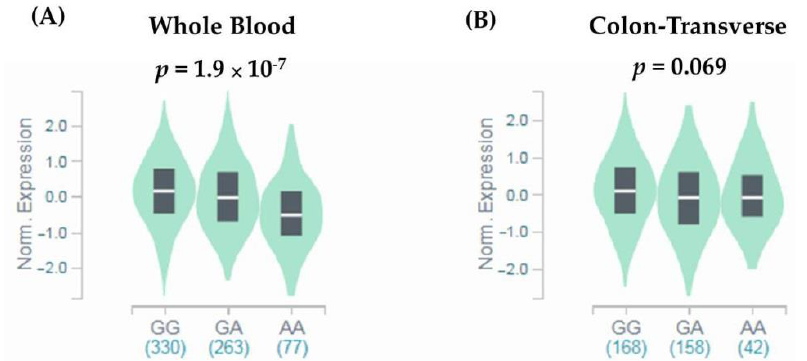
Figure 1. rs351855 regulates the expression of FGFR4. eQTL analysis of rs351855 in representative ( A ) whole blood and ( B ) colon tissues based on data from the GTEx portal. p -Values are calculated with the linear regression model.